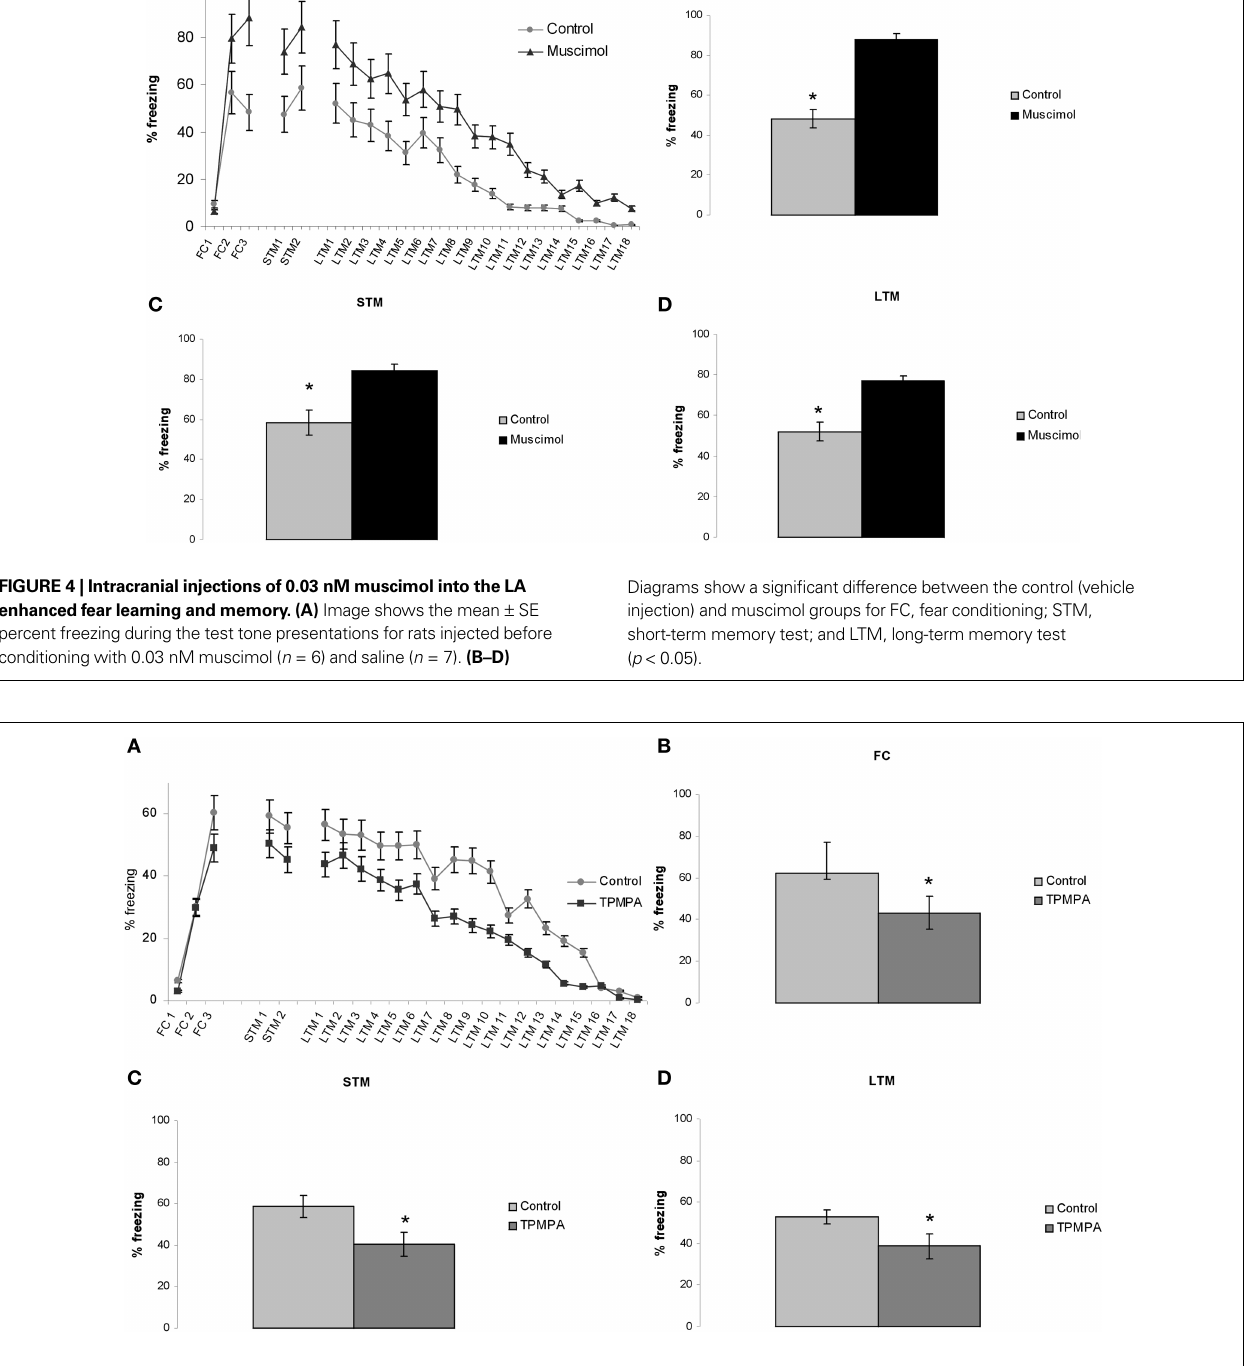
FIGURE 5 | Intracranial injections of 30 nM TPMPA into the LA impaired fear learning and memory. (A) Whole experiment with mean ± SE percent freezing levels for injections of 30 nM TPMPA ( n = 7) and control ( n = 6). (B–D) Diagrams show TPMPA impaired fear learning for FC, fear conditioning; STM, short-term memory test; and LTM, long-term memory test ( p <